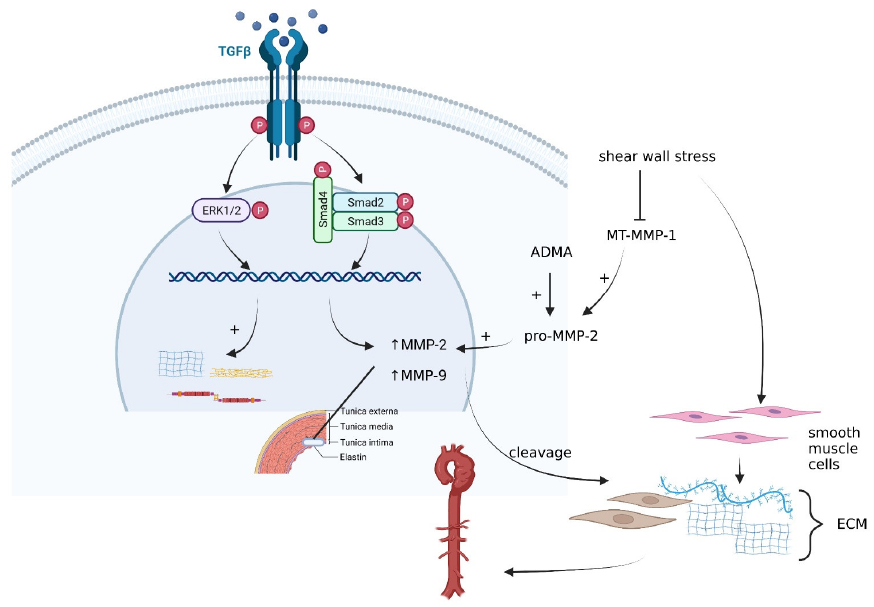
Figure 1. Interconnecting pathways and key effectors of aortic aneurysm development. Created with BioRender.com. Legend: The figure summarizes the consequence of TGF-β activation, which will lead to the activation of ERK1/2- and SMAD-dependent pathways, resulting in the promotion of MMP-2, MMP-9 release, which promote ECM cleavage as well as collagen, elastin and fibronectin synthesis. Shear wall stress stimulates migration of SMCs through the extracellular matrix, resulting also in MT-MMP-1 and, consequently, MMP-2’s reduced expression. ADMA activates the MMP-2 precursor, pro-MMP-2.